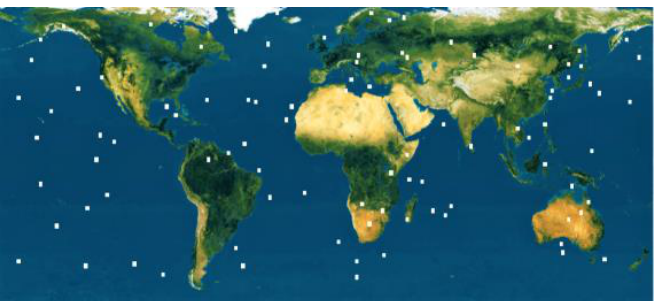
Figure 8. Point target observation